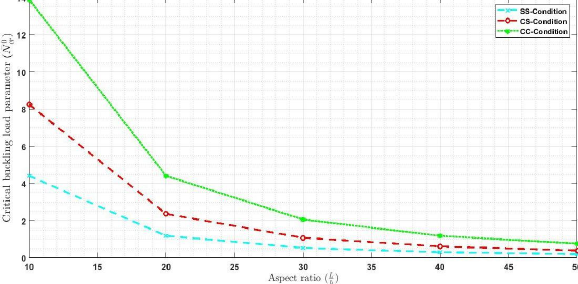
Figure 4: Critical buckling load parameter Vs. aspect